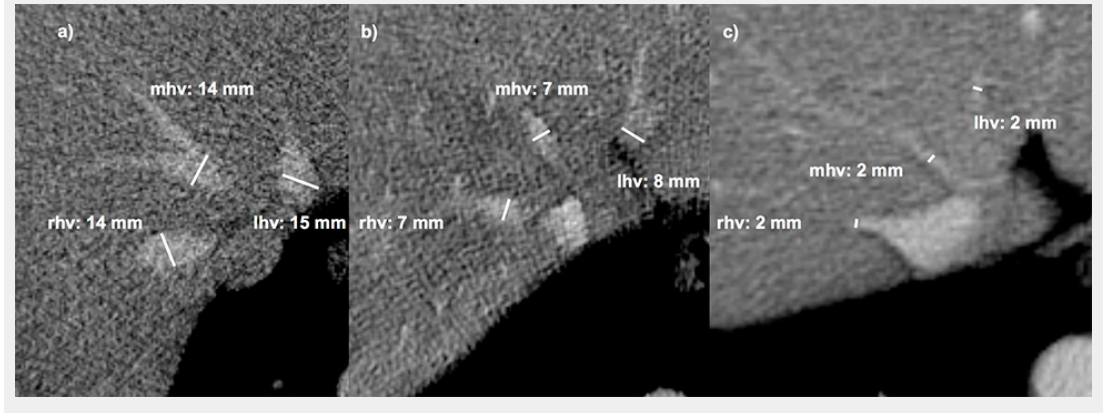
Figure 2 Measurement of the hepatic veins. The three main hepatic veins were measured 1–2 cm before their aperture into the inferior caval vein. Accessory veins were not included. (a) normal liver,(b) liver fibrosis grade 2, (c): liver cirrhosis Child b. rhv, mhv, lhv = right, middle and left hepatic vein